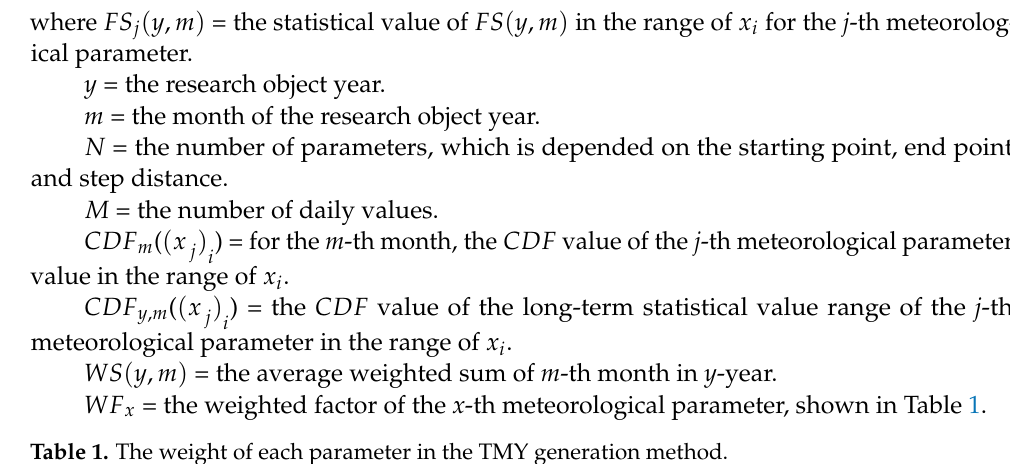
Table 1. The weight of each parameter in the TMY generation method. Meteorological